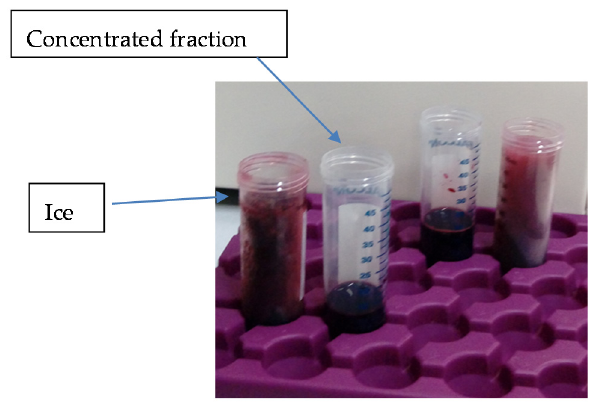
Figure 3. Ice and concentrate fractions from two of the time–temperature combinations studied. The ice fraction and concentrated fraction at 5 °C for 10 min (left) and the ice fraction and concentrated fraction at 15 °C for 20 min (right).